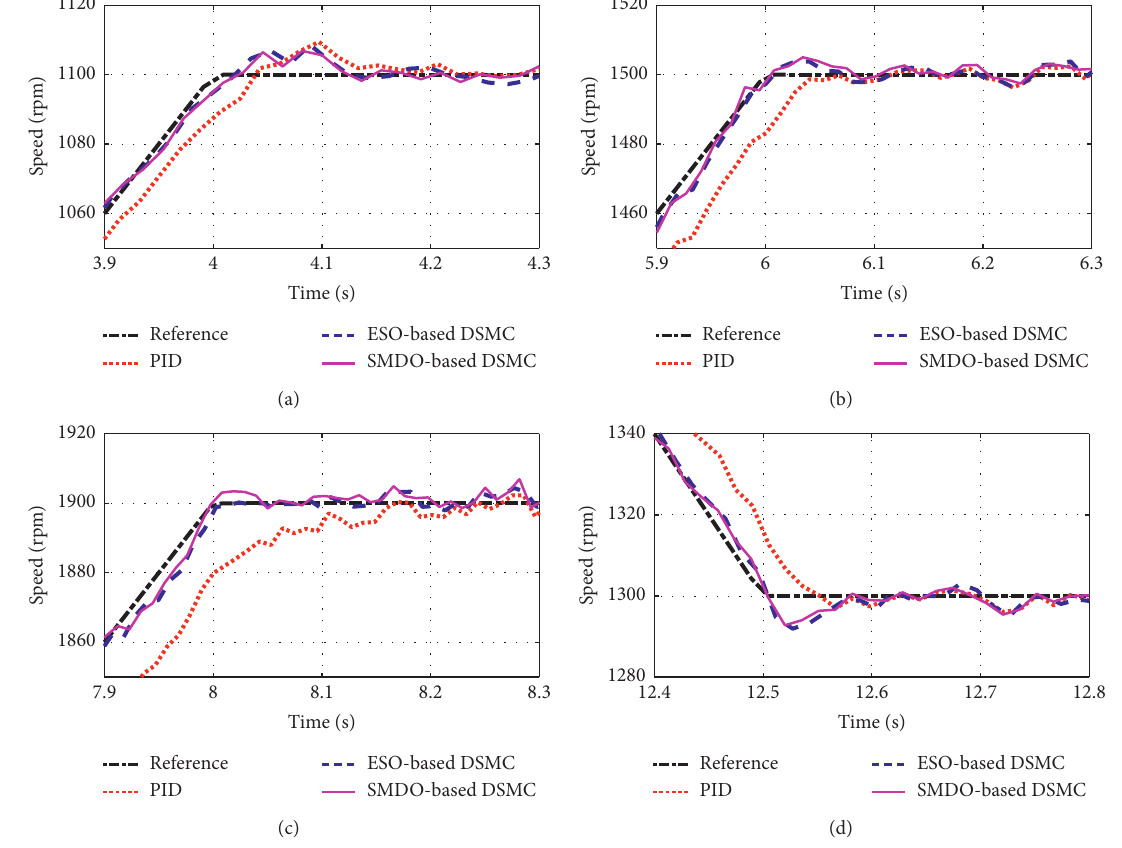
Figure 10: Diesel engine speed response during acceleration and deceleration processes. (a) 700–1100rpm. (b) 1100–1500rpm. (c) 1500–1900rpm. (d)